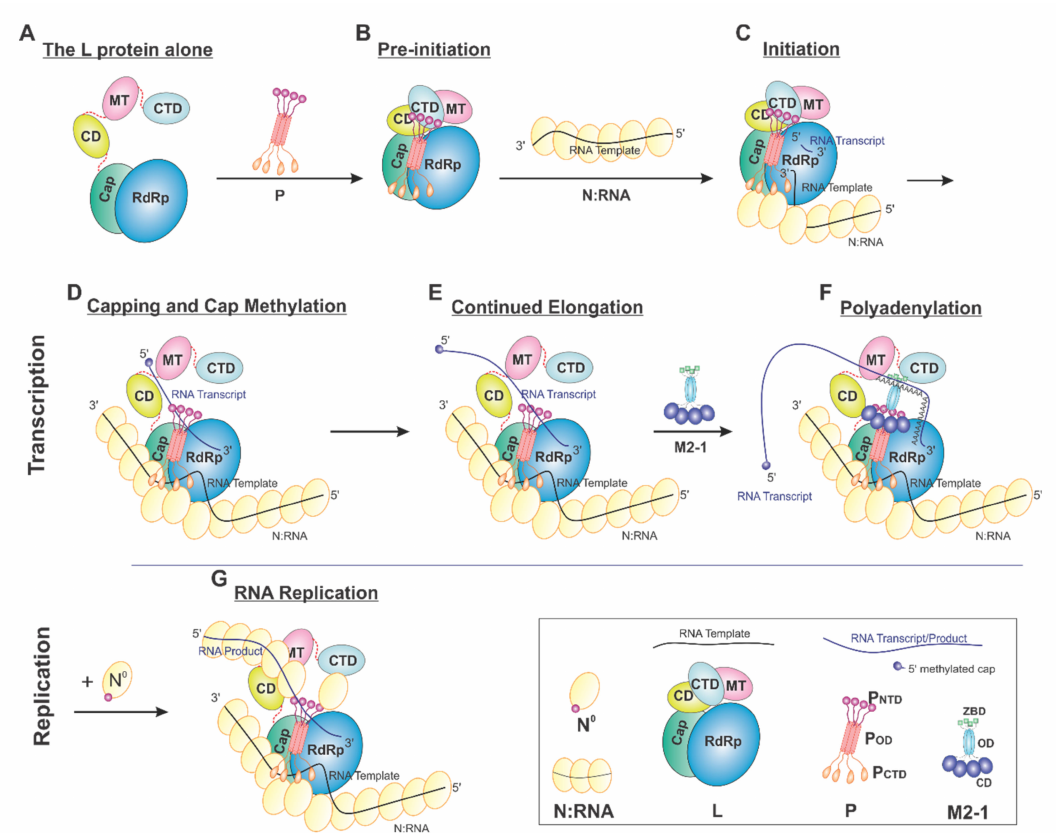
Figure 7. Proposed cartoon models of RSV RNA synthesis. The RNA template, RNA transcript, and the flexible linker are shown in the black, blue, and red lines, respectively. ( A ) The L protein alone: The cartoon depicting the conformational flexibility of the connector domain (CD), the methyltransferase domain (MT), and the C-terminal domain (CTD) of L. ( B ) Pre- initiation: conformational rearrangements of the flexible domains upon binding of the tetrameric P protein. ( C ) Initiation: the priming loop of the Cap domain is at the close approximate of the de novo initiation site of the RdRp domain. ( D ) Capping and cap methylation: the Cap and flexible domains, in particular, the MT domain, rearranged to catalyze the cap addition and cap methylation. ( E ) Continued elongation: after the proper cap, the elongation stage of the transcription continues. The flexible domains again become flexible. ( F ) Polyadenylation: the recruitment of M2-1 when polyA transcript is synthesized. ( G ) RNA replication: upon the supply of the N ◦ (RNA-free N), the RNA replication